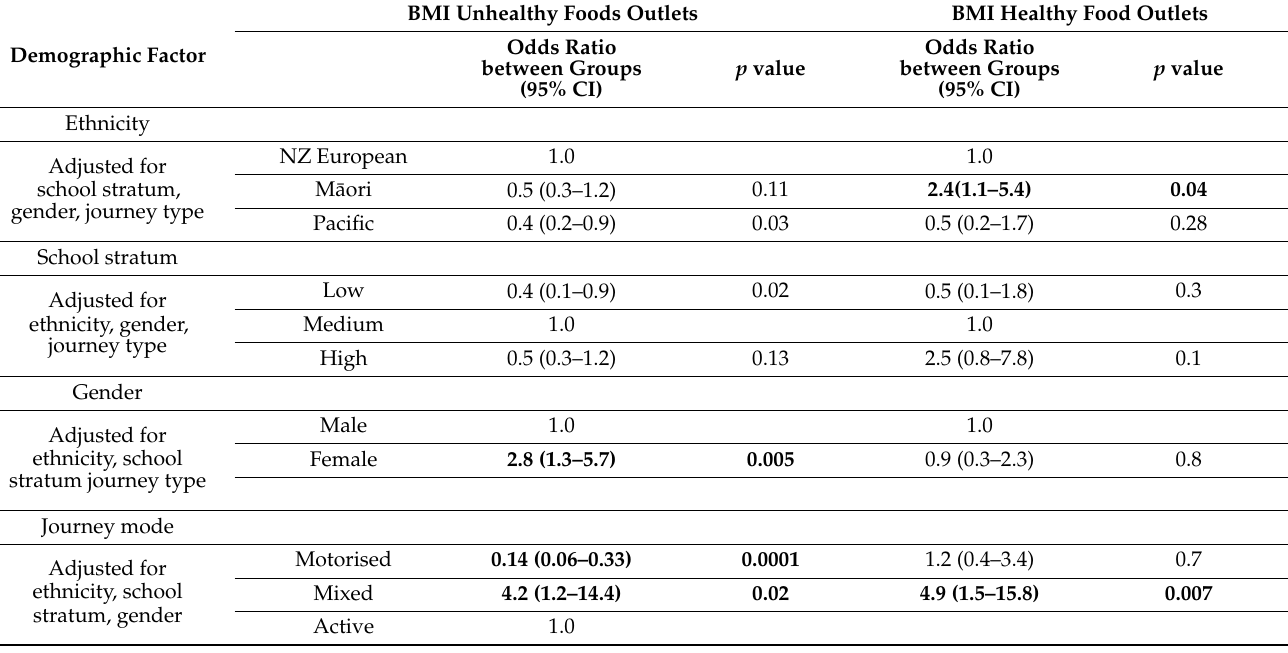
Table 4. Odds ratios (with 95% confidence intervals) from logistic regression models for exposure to BMI unhealthy food outlets and BMI healthy outlets per journey adjusted for journey type, gender, ethnicity and school tertile